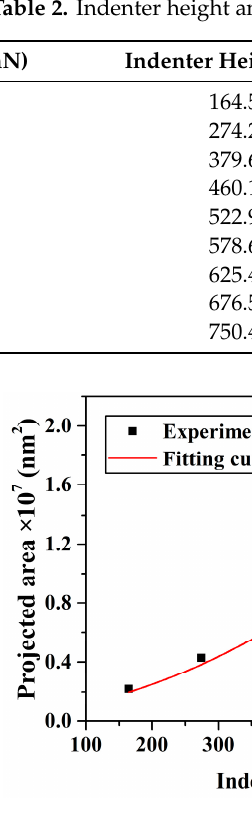
Table 1. Scratch test parameters.